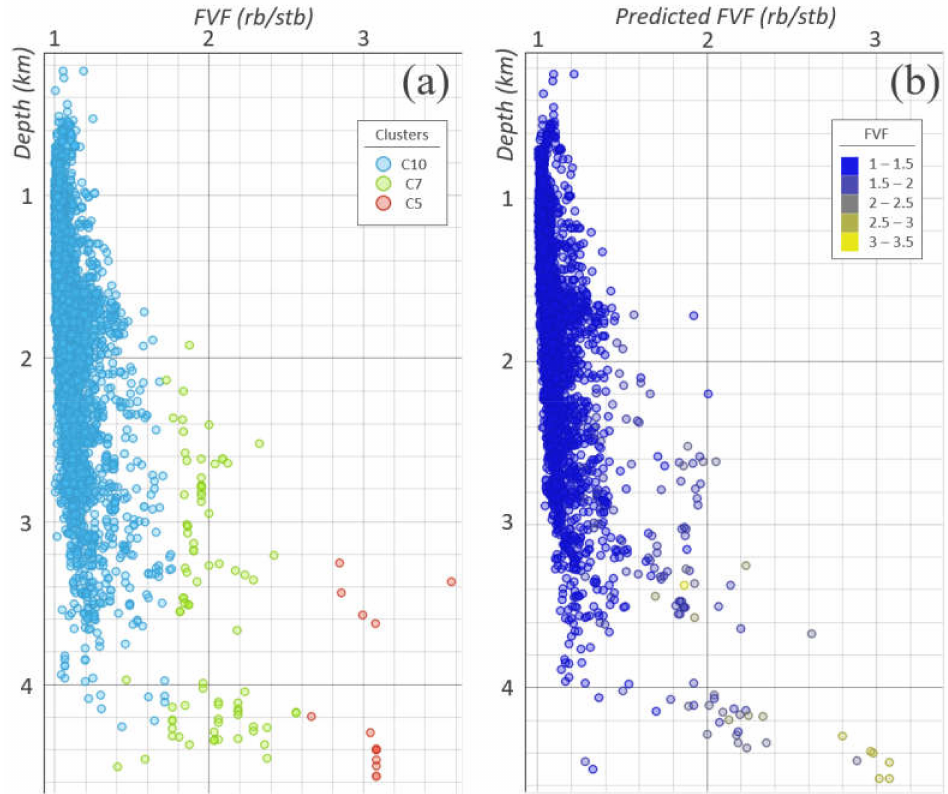
Figure 17. Results from random forest learning. ( a ) Recorded FVF values plotted against depth. Hierarchical clustering was used to remove outliers. Three clusters (C10, C7 and C5) were used for model training. ( b ) FVF predictions (based on API, depth, temperature and viscosity data) plotted against depth. Data points are coloured based on their actual recorded FVF value. Some regions of incorrectly predicated values are identified, particularly at greater depths. Cross-plots modified from Orange Data Mining software